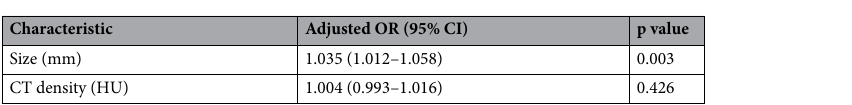
Table 4. Multivariable analysis of training dataset for the conventional CT model (size and CT density) predicting the cardiac tumor.